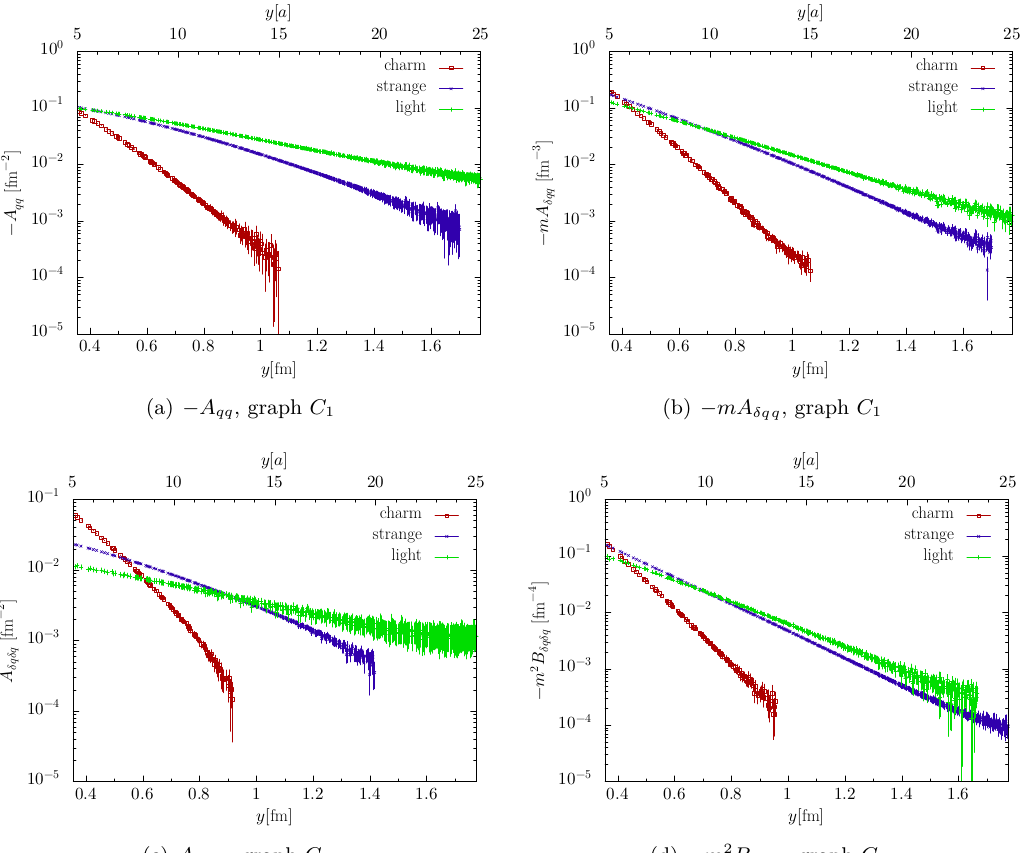
Figure 17 . Mass dependence of twist-two functions for graph C 1 .